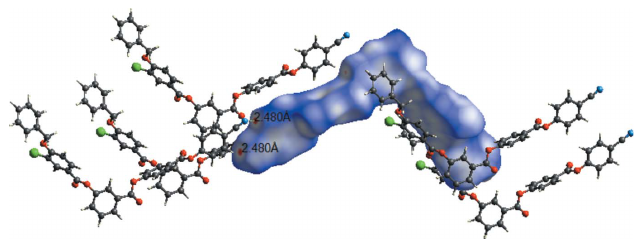
Figure 6 Hirshfeld surface of the title compound mapped over d norm , showing the C—H (cid:3)(cid:3)(cid:3) N interactions.